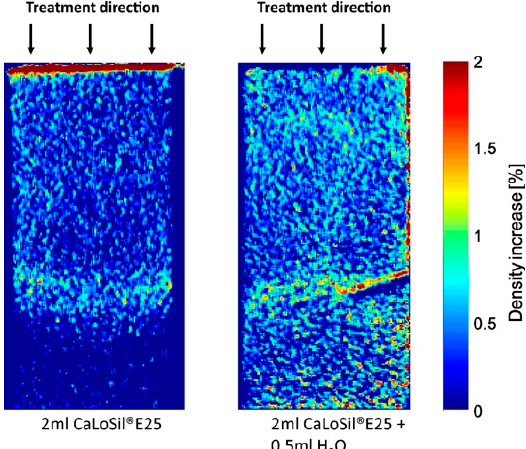
Figure 7. Carrara marble specimens under field exposure testing [38].